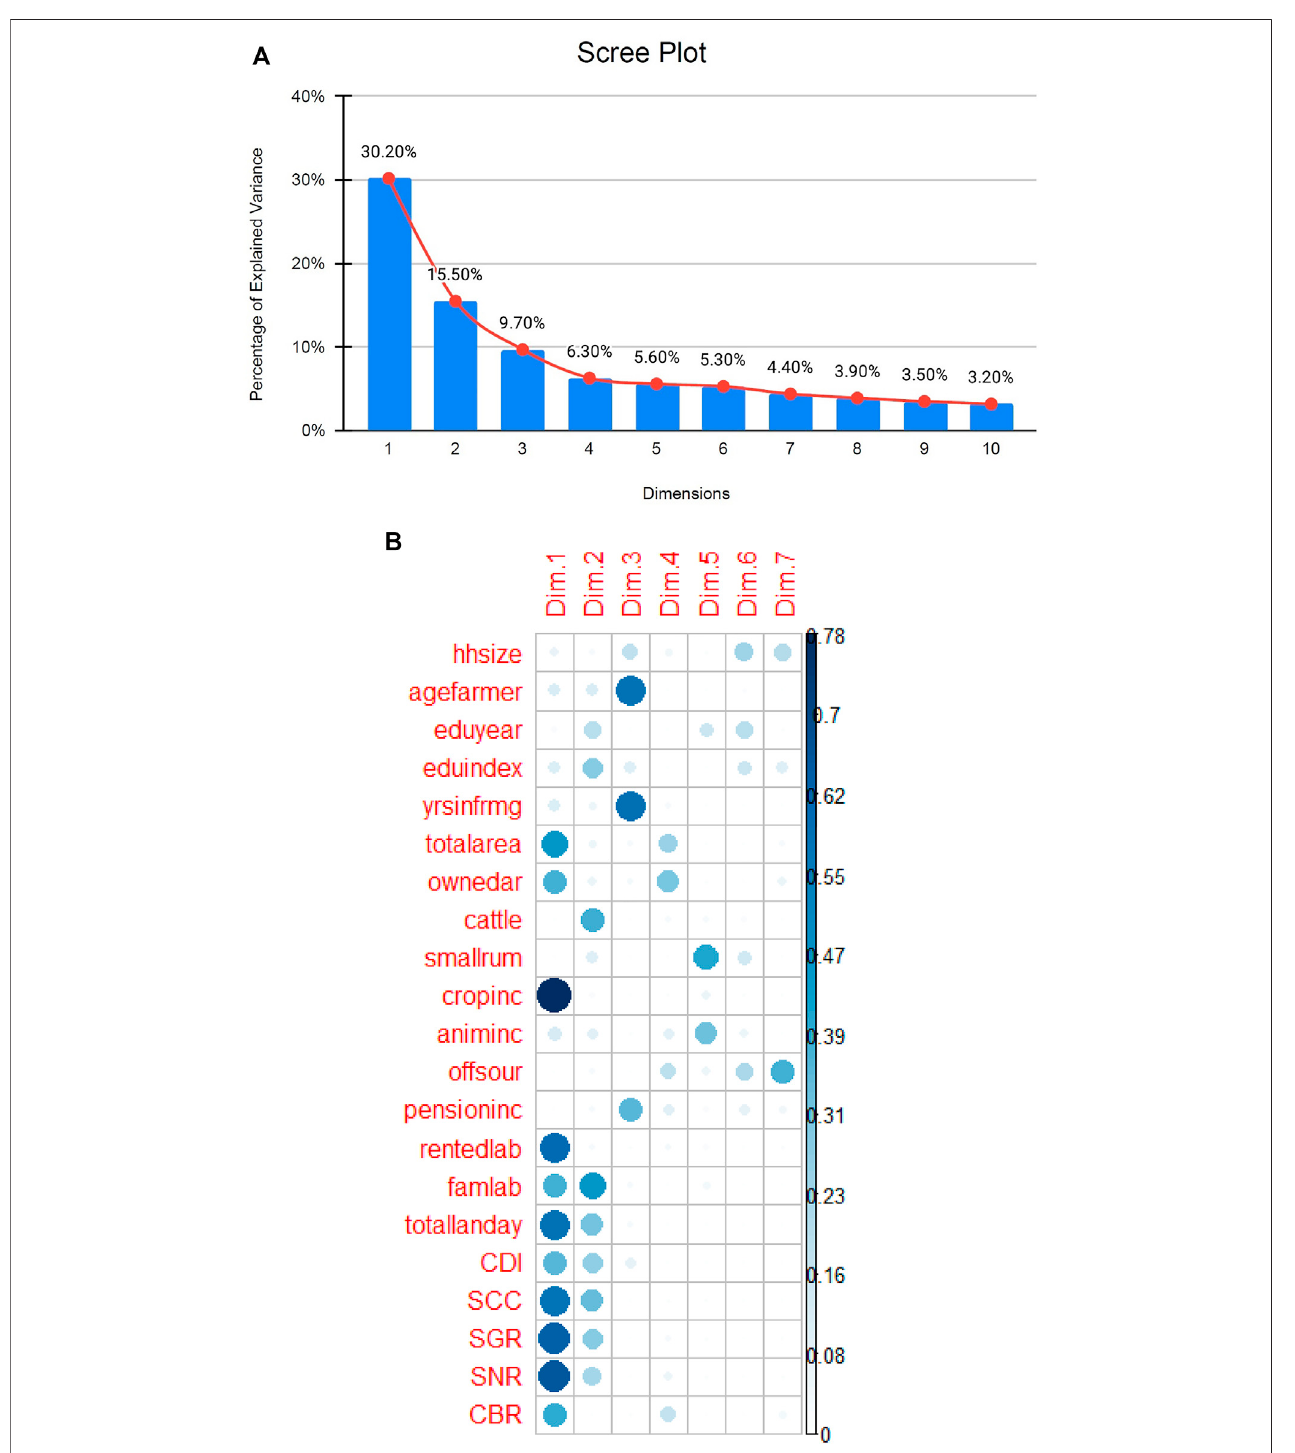
FIGURE3| OutputofPCAresult. (A) Screeplotshowingthecumulativevarianceexplainedbyeachprincipalcomponentinthestudy. (B) Thecorrelationplotofthe variables and components